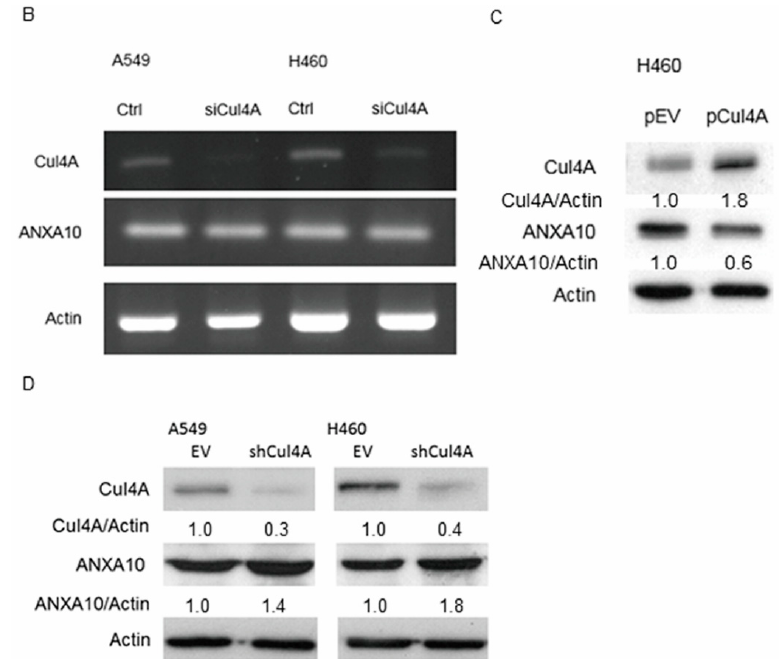
Figure 2. Cul4A knockdown is associated with elevated ANXA10 protein in lung cancer cells. ( A )